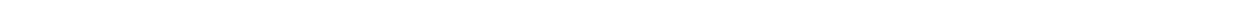
Fig. 5 Position of Dsg1 at the cell – cell interface regulates adherens junction contractility. a Immuno fl uorescence staining of vinculin and Flag (insets)